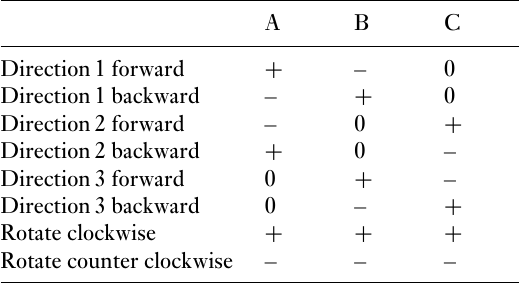
Figure 13 One-step cycle of forward motion of the robot. Table 1 The control strategies of